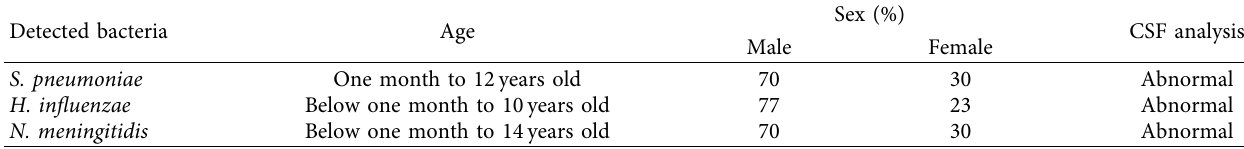
Table 3: Demographic data of positive for PCR